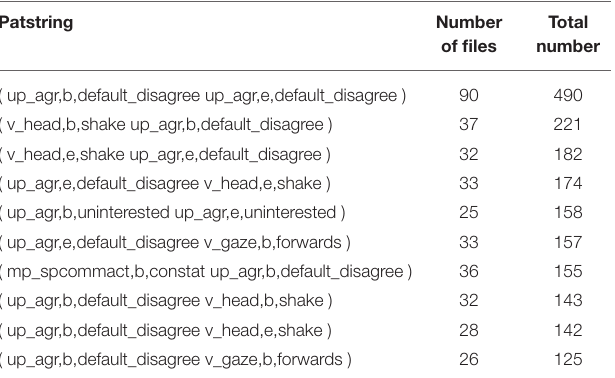
TABLE 10 | The most frequent patterns of agreement consisting of 2 events.